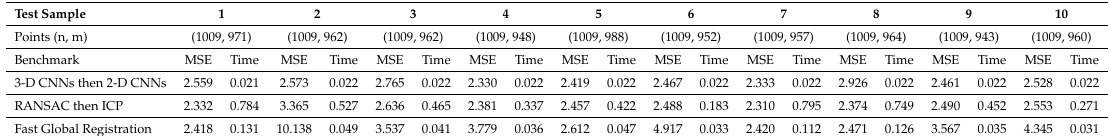
Table 3. The comparisons about MSE and computation time of “Horse” data for test samples from 1 to 10. TestSample